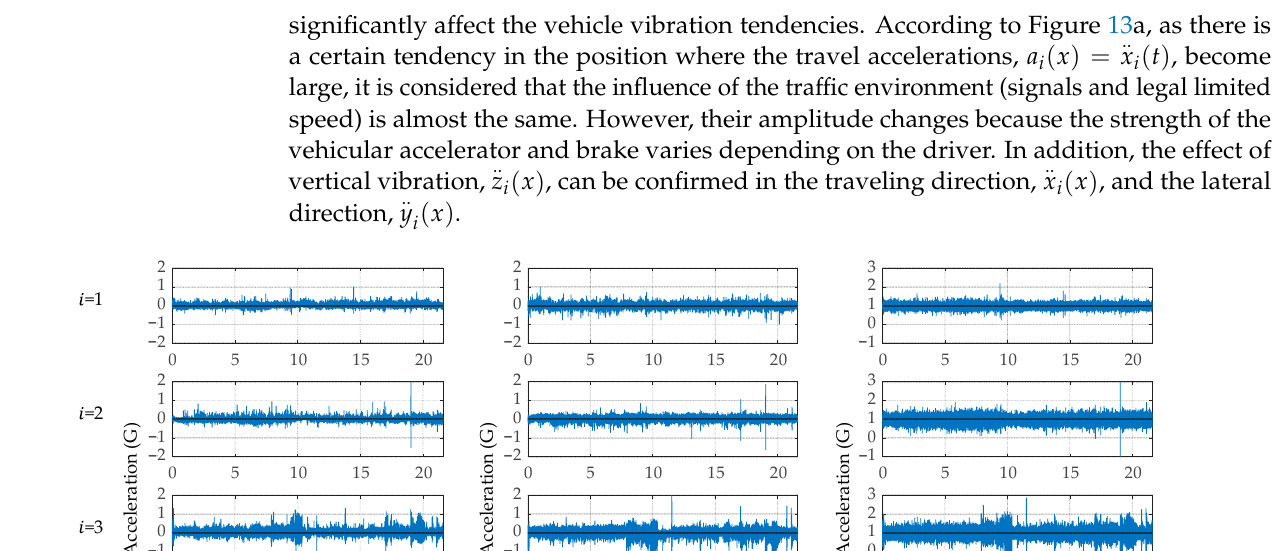
Figure 13. The spatially synchronized vehicle vibration data: ( a ) travel direction, 𝑥(cid:4663) (cid:3036) (cid:4666)𝑥(cid:4667) = 𝑎 (cid:3036) (cid:4666)𝑥(cid:4667) ; ( b ) lateral direction, 𝑦(cid:4663) (cid:3036) (cid:4666)𝑥(cid:4667) ; ( c ) vertical direction, 𝑧(cid:4663) (cid:3036) (cid:4666)𝑥(cid:4667) .